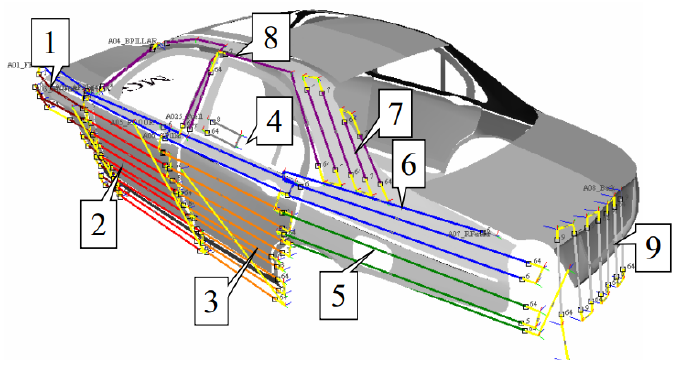
Figure 15. Optimized trajectory on the left and the left ‐ rear parts of the automobile.